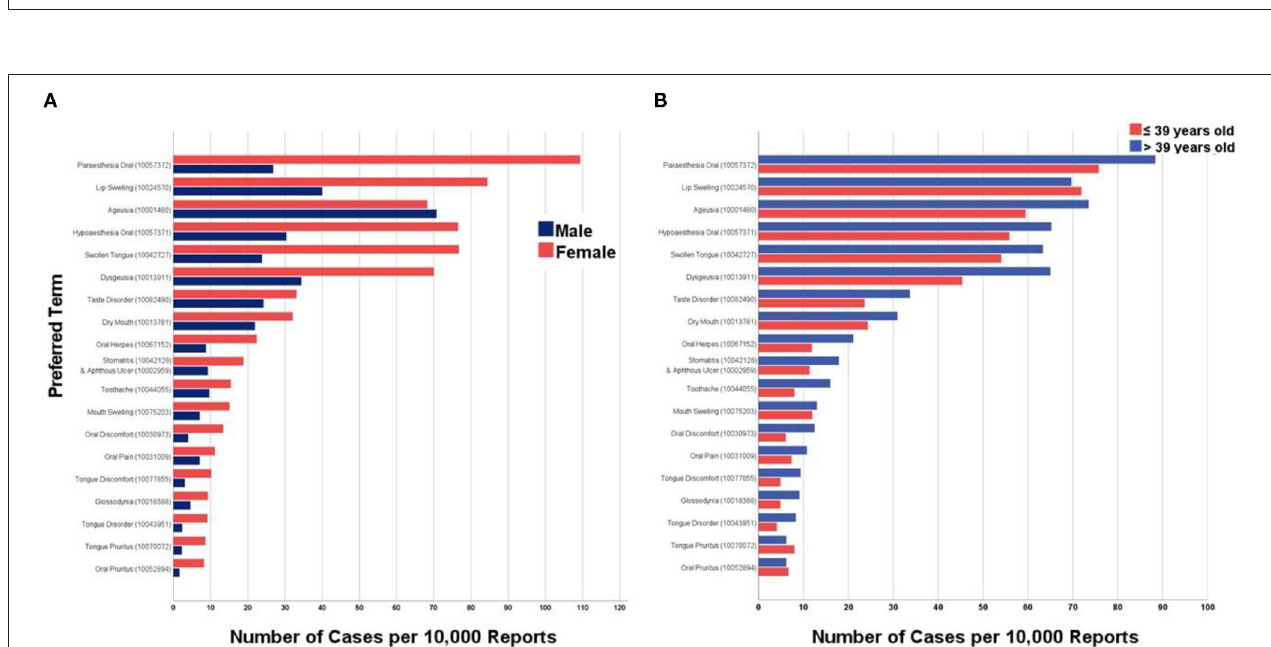
FIGURE 3 | Top twenty oral adverse events reported after COVID-19 vaccination in the United States stratified by (A) Sex and (B) Age Group, January–December 2021 (CDC; VAERS-WONDER).